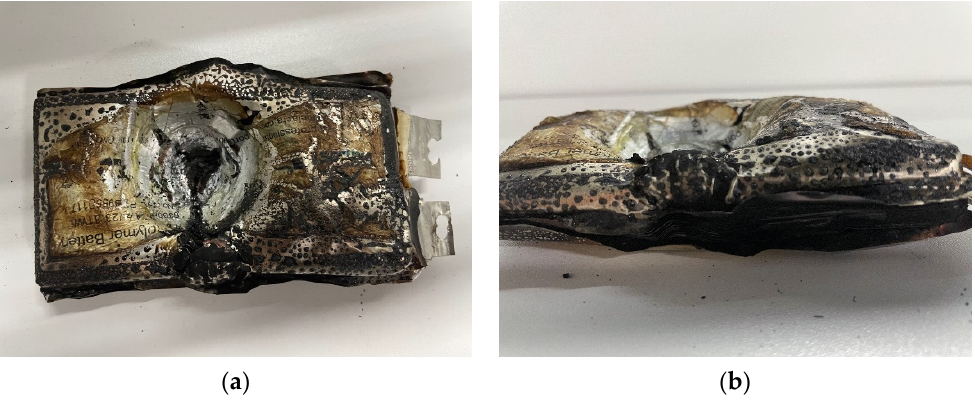
Figure 18. Photograph of battery after testing. ( a ) Front; ( b ) Side.